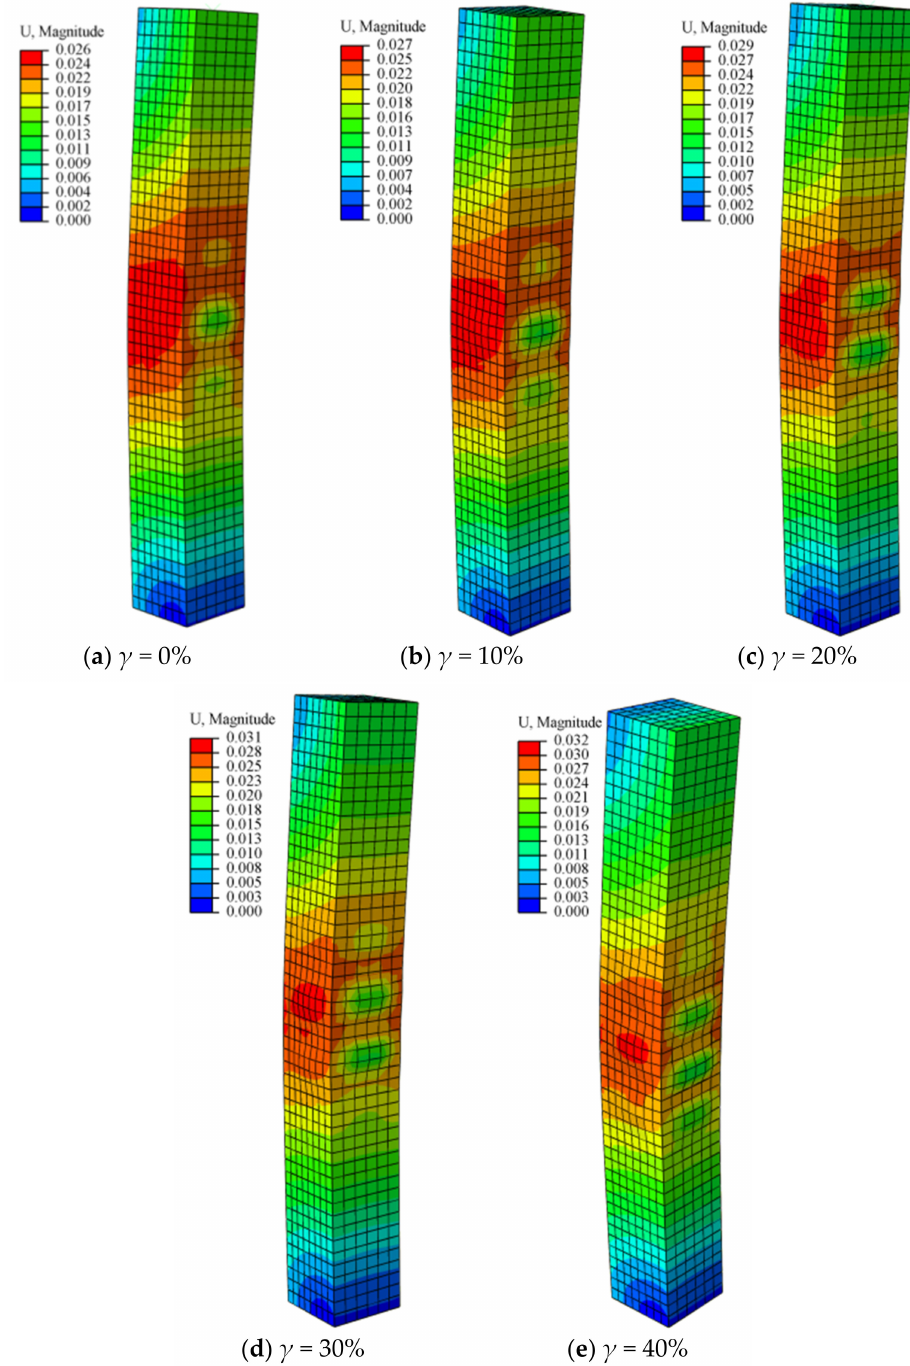
Figure 4. Schematic diagram of the failure mode of concrete-filled square steel tube long column subjected to eccentric loads with different corrosion rates ( a ) γ = 0%; ( b ) γ = 10%; ( c ) γ = 20%; ( d ) γ = 30%; ( e ) γ = 40% (U is the buckling displacement, unit: